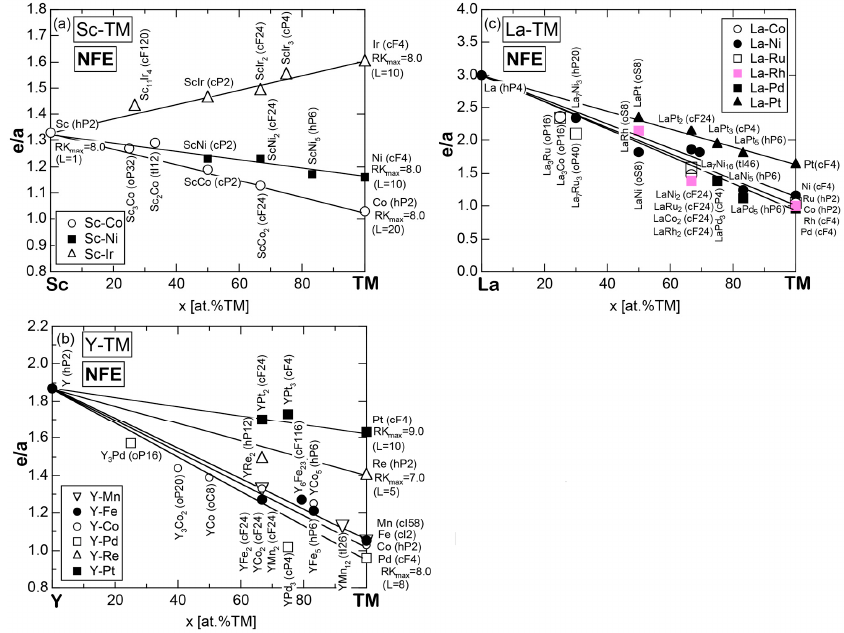
for elements and compounds. Crystals 2017 , 7 , 9